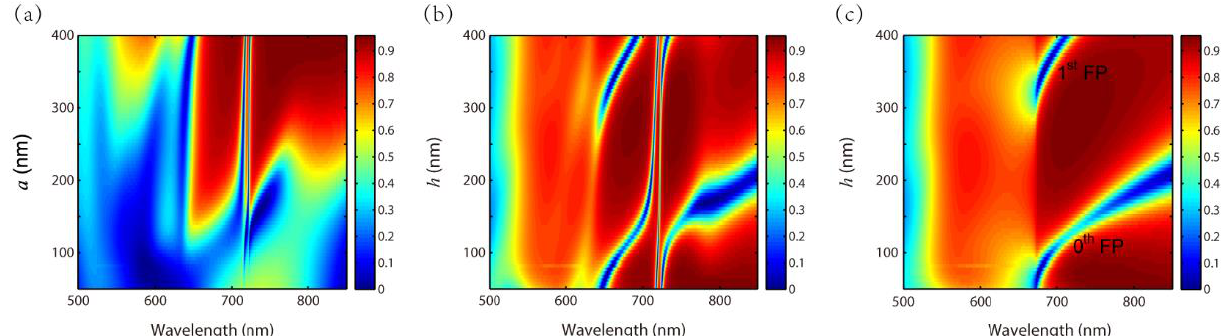
Figure 9. Reflection spectra with different ( a ) a and ( b ) h of the proposed nanosystem; ( c ) Reflection spectra with different h of a nanosystem with Au grating and a fluoropolymer substrate.